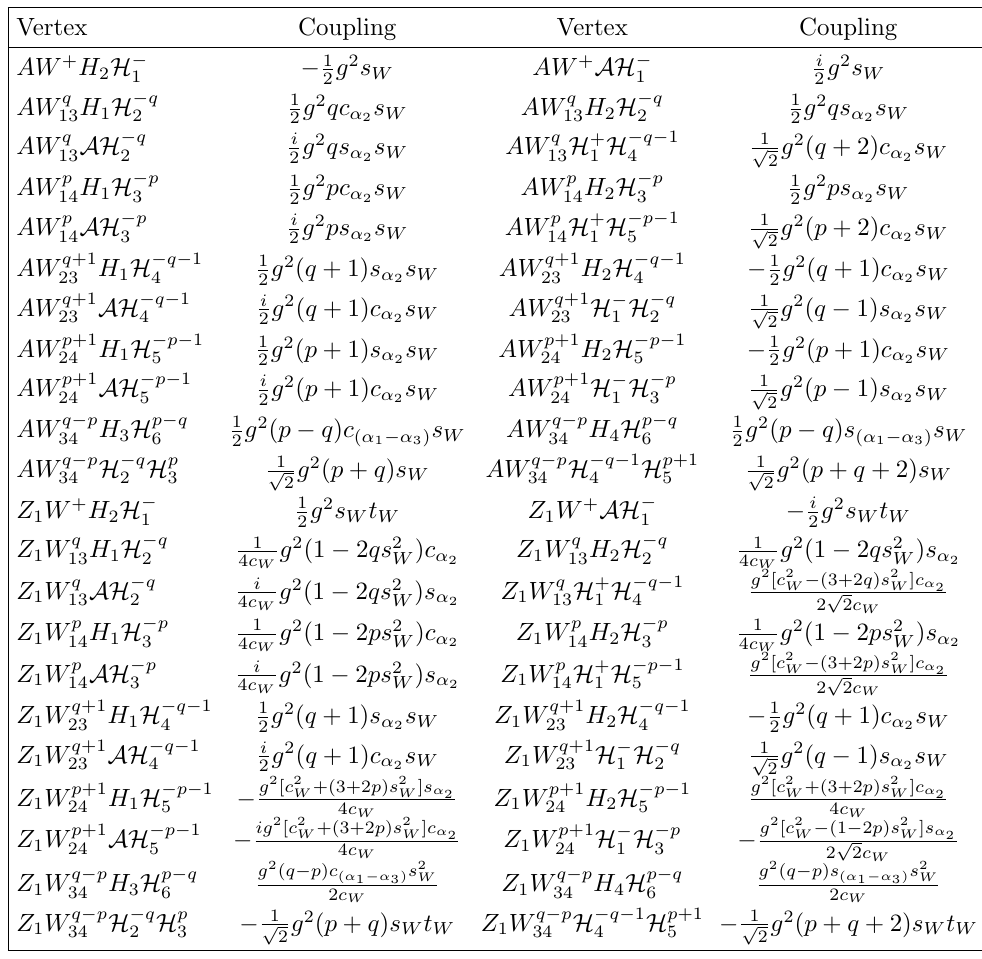
Table 15 . The interactions of a neutral and a charged gauge boson with two scalars (table contin-